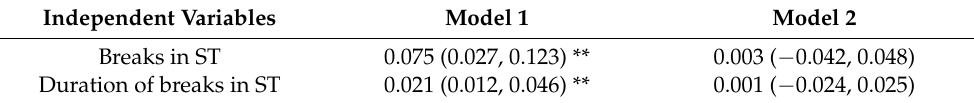
Table 6. Exploration of the intensity attribute of the duration of breaks in ST in girls. Independent Variables Model 1 Model 2 Breaks in ST 0.075 (0.027, 0.123) ** 0.003 ( − 0.042, 0.048) Duration of breaks in ST 0.021 (0.012, 0.046) ** 0.001 ( − 0.024,